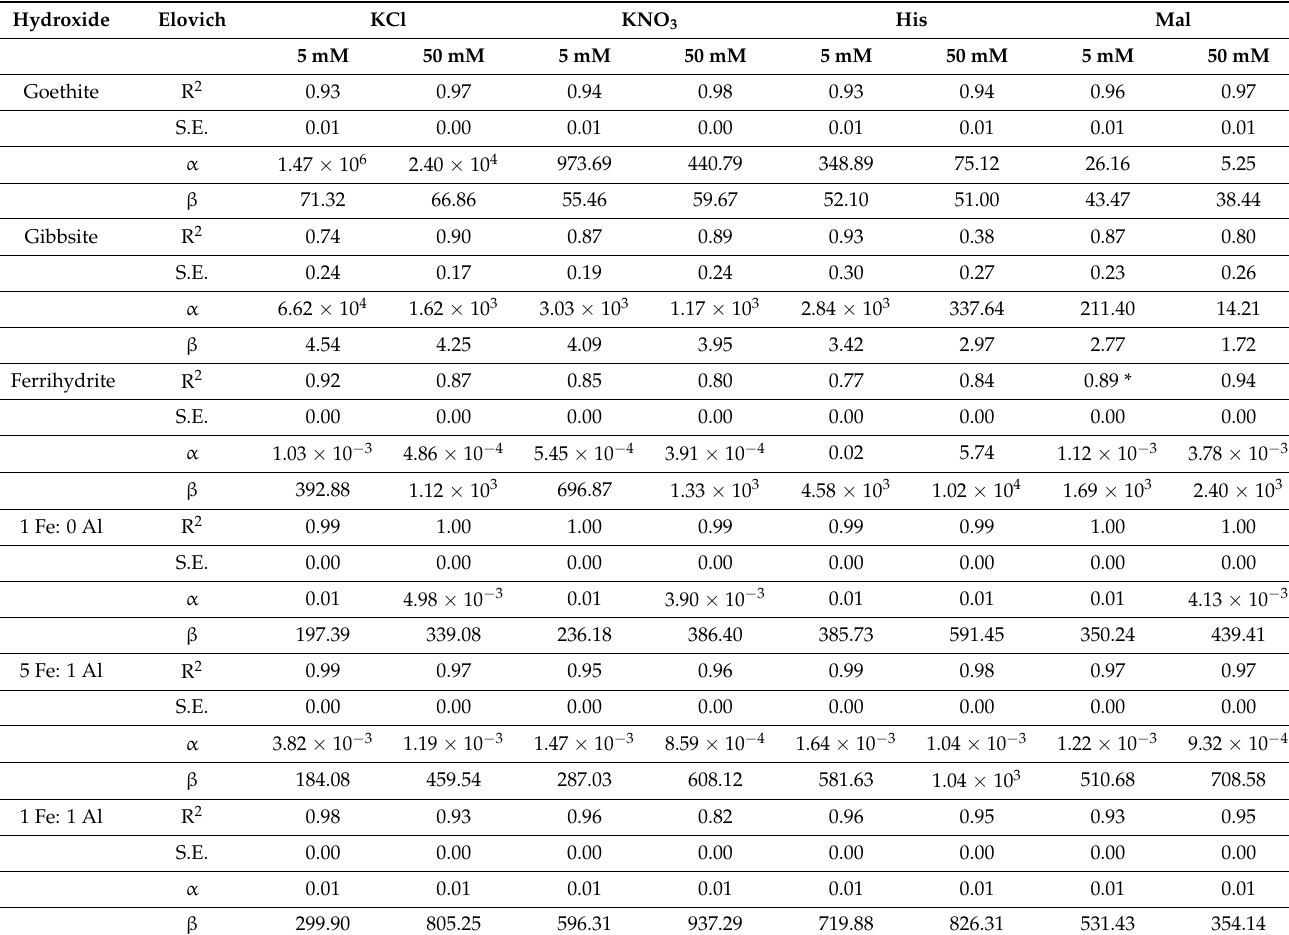
Table 4. Coefficients of determination (R 2 ), standard error (S.E.), and calculated kinetic parameters for the Elovich equation used to describe the kinetic release of P after 336 h desorption